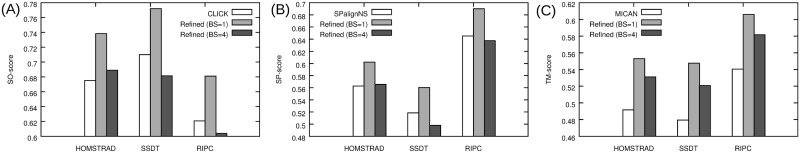
Scores of refined alignments.The alignments of CLICK, SPalignNS, and MICAN were refined by optimizing SO-score, SP-score and TM-score respectively. The block size were restricted to either 1 (BS = 1) or 4 (BS = 4). The bars show the average scores of the alignments measured from the three test sets.